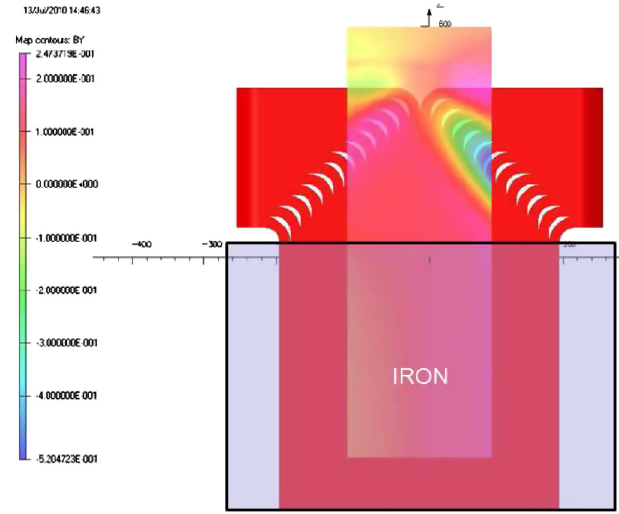
FIG. 47. Vertical stray field experienced by the circulating particles. The septum is shown from underneath, the light blue area indicates the part which is covered by the iron